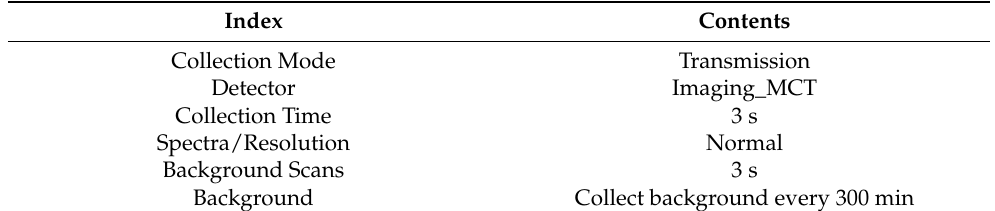
Table 1. FT-IR settings for microplastic analysis.